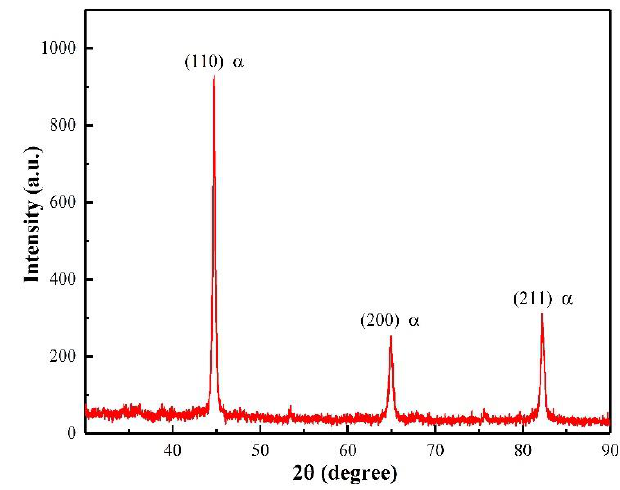
Figure 3. XRD pattern of the base metal.